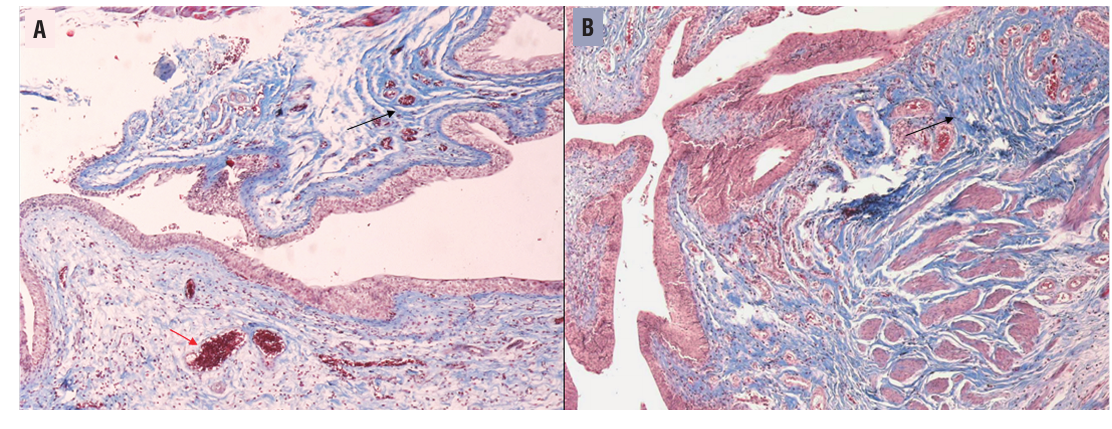
Figure 3 – Histopathological slide of a rat urinary bladder from both the control (A) and copaiba (B) group. Note the collagen fibers (black arrow) and the vascular proliferation (red arrows). Masson's trichrome stain 20x.